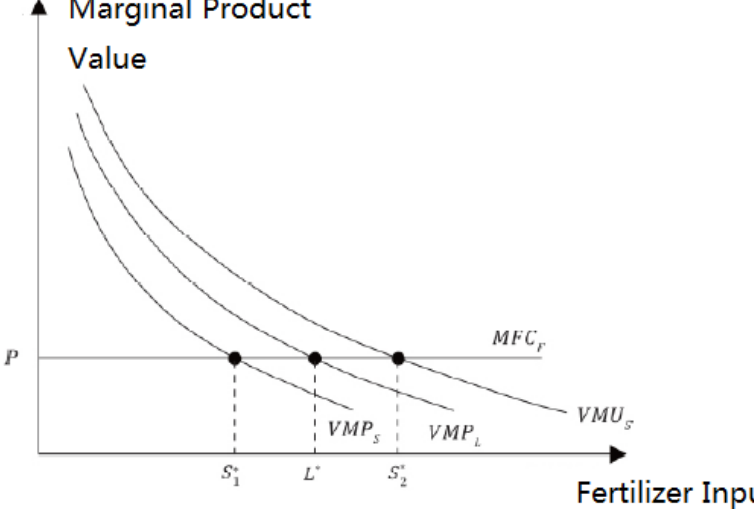
Figure 1. The relationship between fertilizer input and marginal product value. However, as most small-scale households follow the semi-self-sufficiency model, the decision first needs to satisfy the self-sufficient consumption needs, and then seek to maximize family utility. Although small-scale households mainly rely on non-agricultural income for their family income, however, there is a high extent to which they rely on self-produced food and they pay more attention to ensuring family food security through the quantity and quality of self-produced food. Therefore, the utility brought by each unit of product cannot be simply measured by its market price, and the marginal product value curve corresponding to small-scale households should include two parts: the marginal product economic value and the household food safety utility